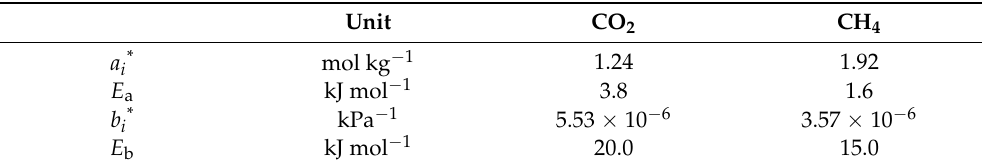
Figure 3. Simulated adsorption isotherms of ( a ) CO 2 and ( b ) CH 4 on CHA-type zeolite with Si/Al = 18.2 at 253 – 473 K. Symbols describe the simulated data, and lines are calculated values by Equation (13) and Table 2. Table 2. Pre-exponential factors and activation energies of CO 2 and CH 4 for the adsorption on CHA-type zeolite with Si/Al =